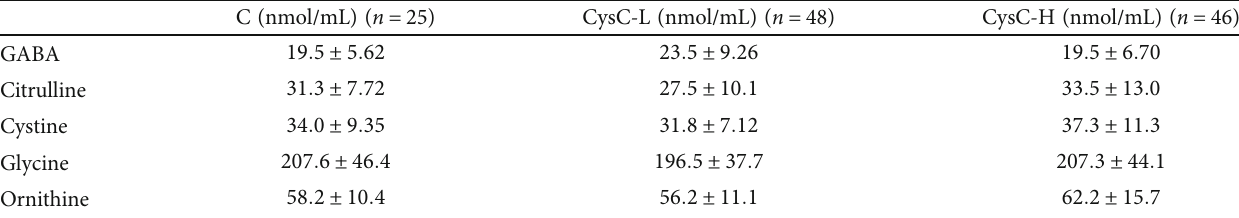
Table 7: Plasma amino acid concentrations in each group.